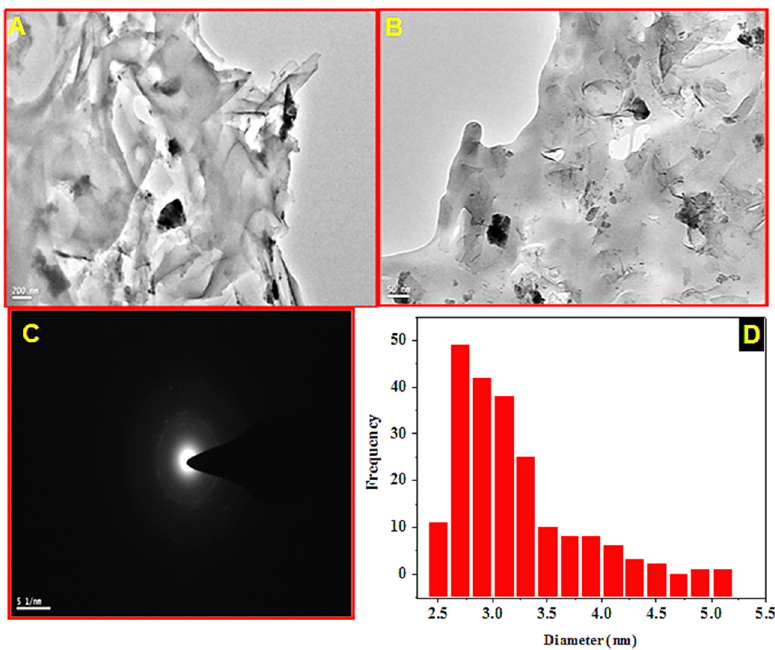
Figure 4. ( A , B ) HR-TEM images (with different magnifications) ( C ) SAED pattern and ( D ) size distribution curve of Met-GO/SA.